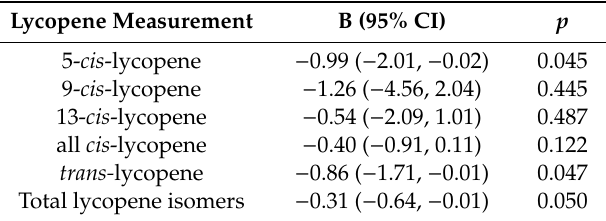
Table 3. Multivariate associations of plasmatic lycopenes with carotid plaque burden in the 105 diabetic subjects included in the